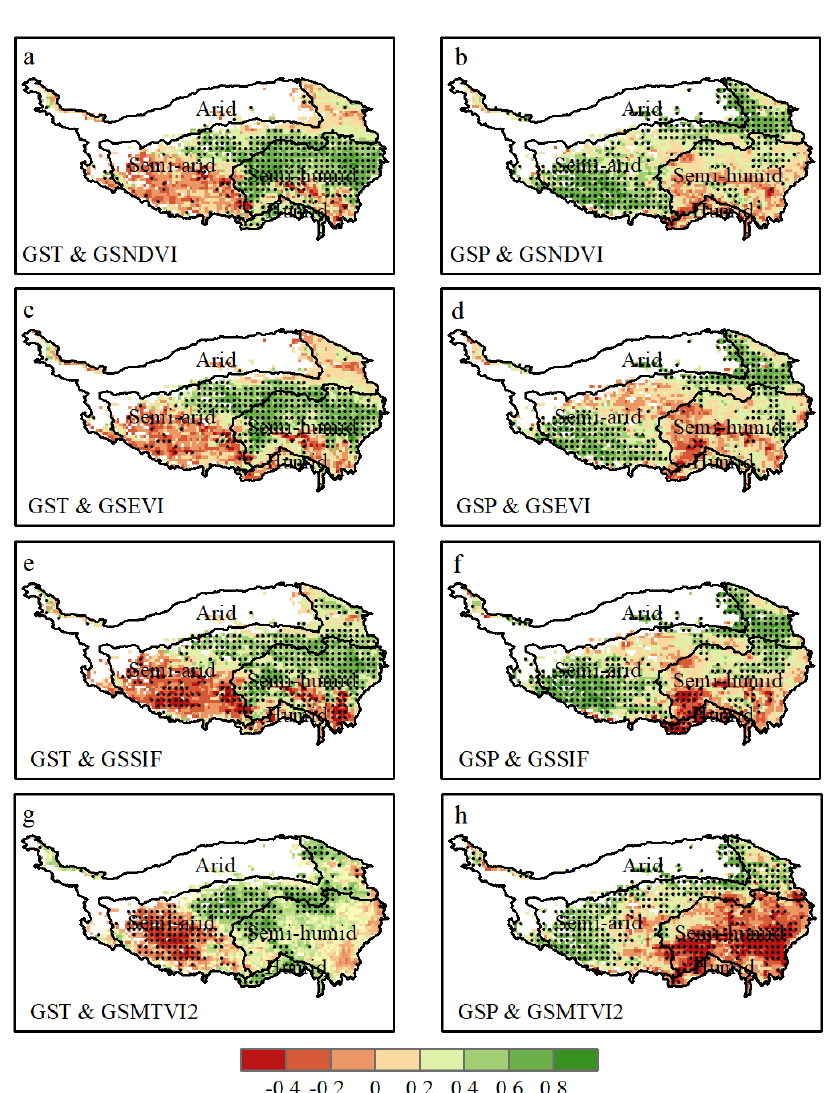
Figure 3. Spatial patterns of sensitivity of the vegetation indices to GST and GSP during 2000–2019. ( a , c , e , g ) show the spatial patterns of climatic sensitivity of GSNDVI, GSEVI, GSSIF, and GSMTVI2 to GST, respectively. ( b , d , f , h ) show the spatial patterns of climatic sensitivity of GSNDVI, GSEVI, GSSIF, and GSMTVI2 to GSP, respectively. The black dots indicate the relationship is statistically significant at the 0.05 significance level.